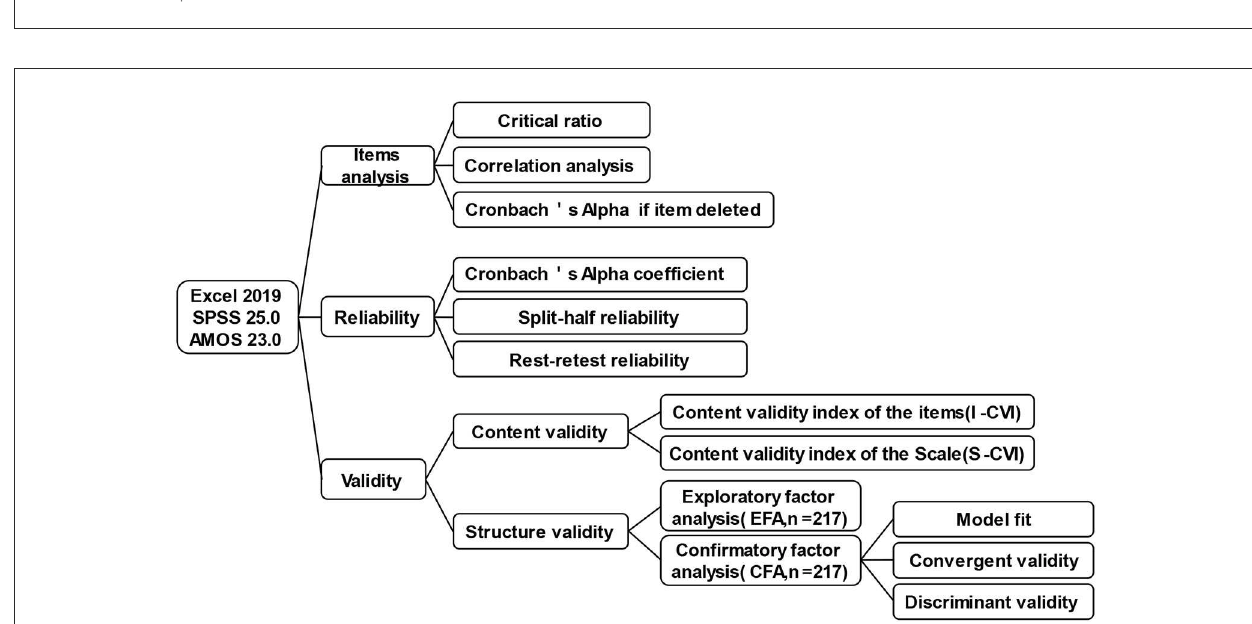
FIGURE2 Data analysis procedure for Chinese DoCCA